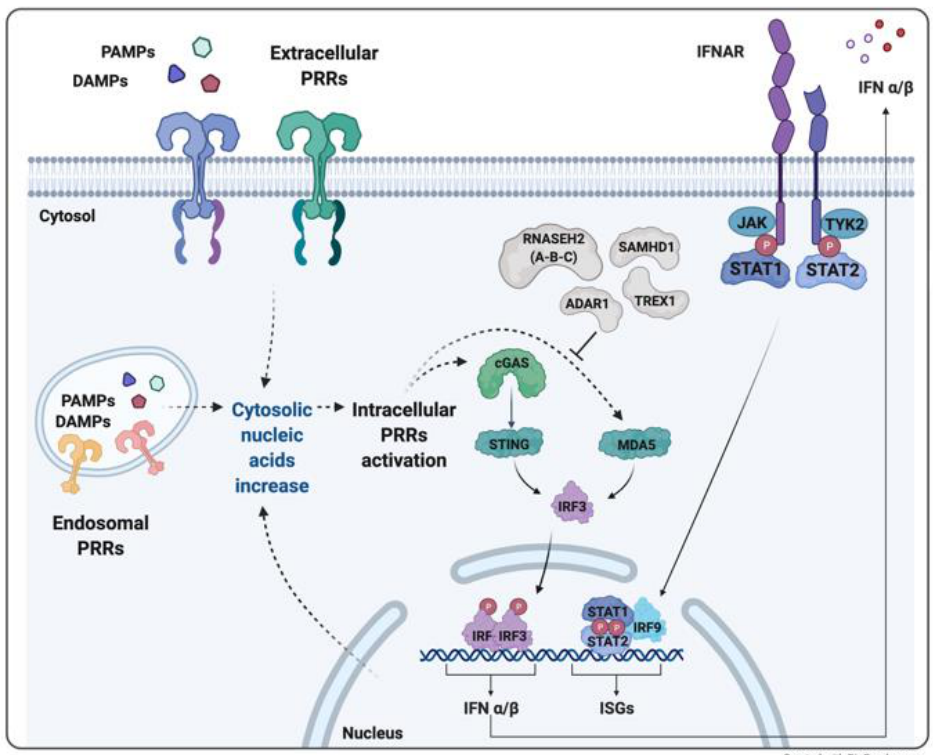
Figure 1. Type I Interferonopathies with neuroinflammation may arise from the gain of function mutations in genes encoding intracellular sensors and adaptors (as IFIH1 gene coding for MDA5 in Aicardi-Goutières syndrome (AGS), and STING in STING-associated vasculopathy with onset in infancy (SAVI)) or loss of function mutations in enzymes involved in nucleotide metabolism which causes an increase of cytosolic DNA (as in AGS due to TREX1 or SAMHD1 mutations), RNA/DNA hybrids (as in AGS due to one of the endonucleases of the RNAseH2 complex) or RNA (as in DADA disease, due to ADAR1 gene). Both mechanisms result in an excessive IRF3-mediated transcription of type I interferons (IFNα/β), which trigger an autocrine and/or paracrine loop of the hyperinflammatory state through IFN-α/β receptor (IFNAR) activation and IFN stimulated genes (ISGs) transcription.